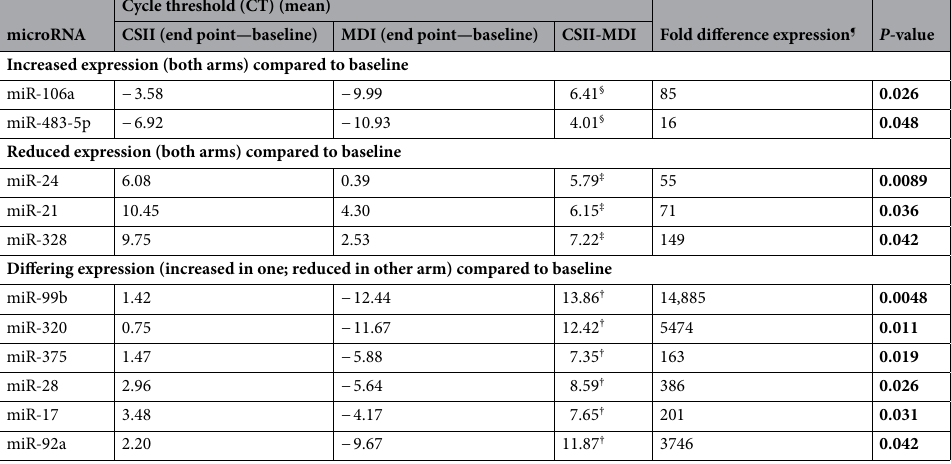
significantly different miRNAs identified during the discovery screen were measured herein (custom TaqMan miRNA qPCR OpenArray panels). Briefly, RNA was isolated using Trizol (Thermo Scientific) on a (QiaCube-HT robot, with RNeasy-HT kit (Qiagen) and ath-miR-172a (spike-in control). RNA concentration was then quanti- fied (Eon spectrophotometer, Biotek, Winooski, VT). Reverse transcription (ath-miR-159a spike-in control), pre-amplification and OpenArray qPCR for microRNAs used a low-sample input workflow 5 . MiRNA expression was normalised to spike-in miRNA controls. Data were analysed using IBM SPSS Statistics (version 23) and Graph Pad Prism (v6.0), including: descriptive statistics, paired and independent T-tests, Mann–Whitney U, Chi-square and Spearman rank correlation tests, with significance at p < 0.05.